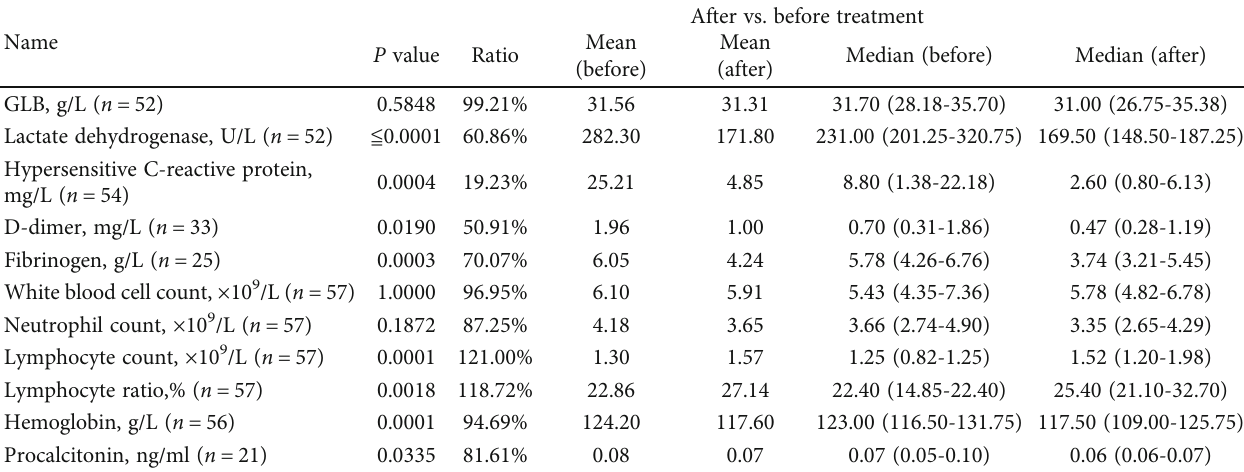
Table 3: Comparison of laboratory indicators before and after treatment.